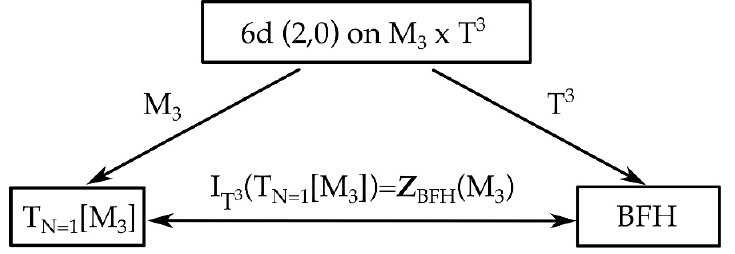
Figure 1 . The setup for the N = 1 3d-3d correspondence is the 6d (2 ; 0) theory on M 3 (cid:2) T 3 . The topologically twisted reduction along M 3 preserves 3d N = 1 and geometrically corresponds to an embedding of M 3 as an associative three-cycle in a G 2 -holonomy manifold. The correspondence states that the Witten index of the resulting theory T N =1 [ M 3 ] can alternatively be computed from the partition function on M 3 of a topological twist of the T 3 -reduction of the 6d theory, a BF-theory coupled to a spinorial hypermultiplet